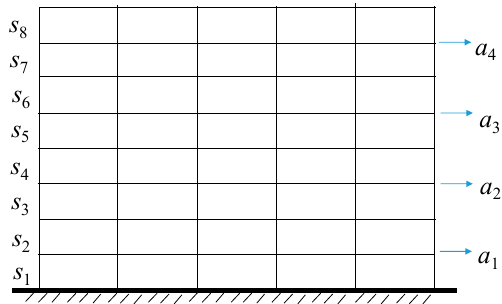
Figure 3. An eight-story steel frame structure model.